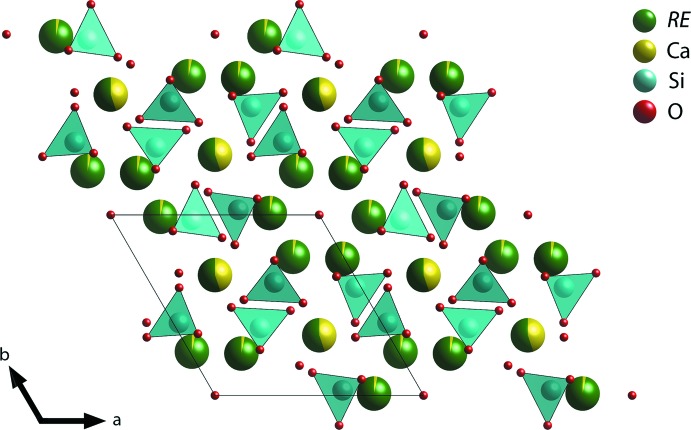
Crystal structure of Ca2
RE
8(SiO4)6O2.